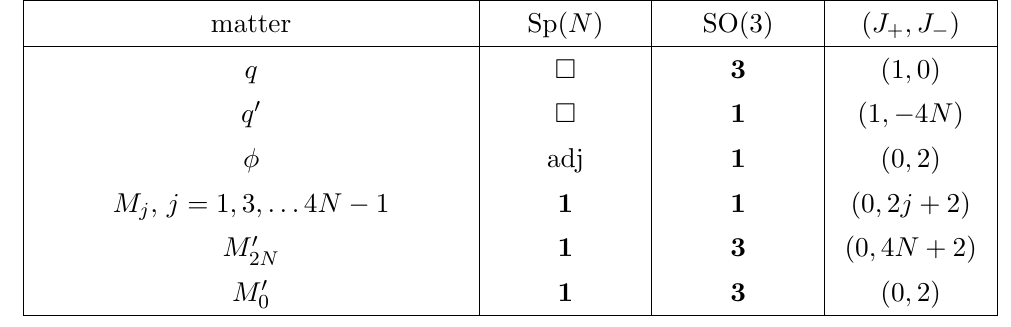
Table 4. The N = 1 matter content for the Sp( N ) gauge theory that (cid:13)ows to ( A 1 ; D 2 N +1 ) Argyres-Douglas